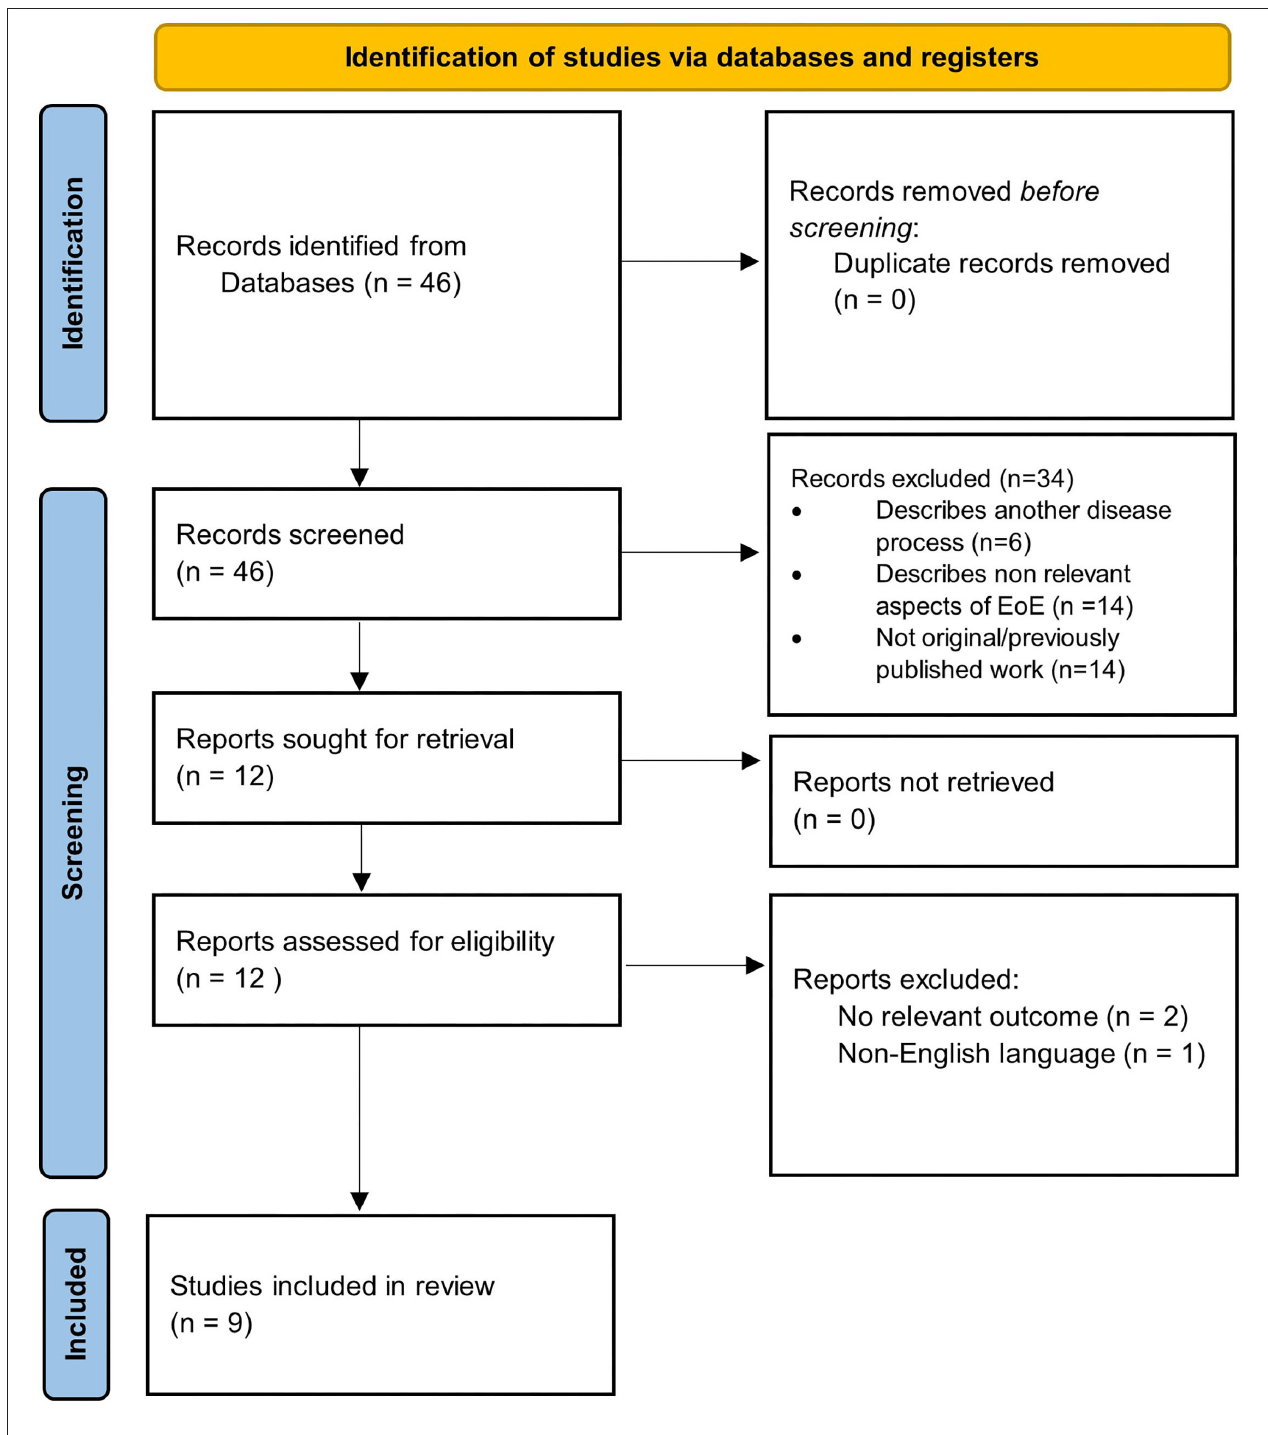
FIGURE 1 | PRISMA 2020 flow diagram detailing selection process of included studies.